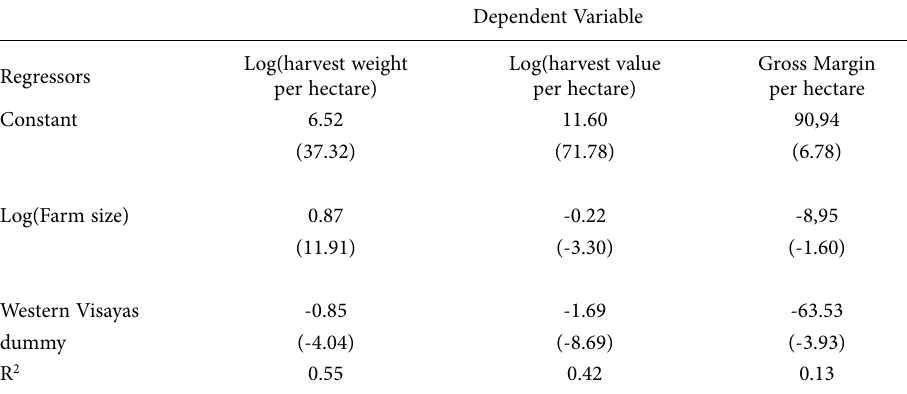
Table 2. Farm Size and Partial